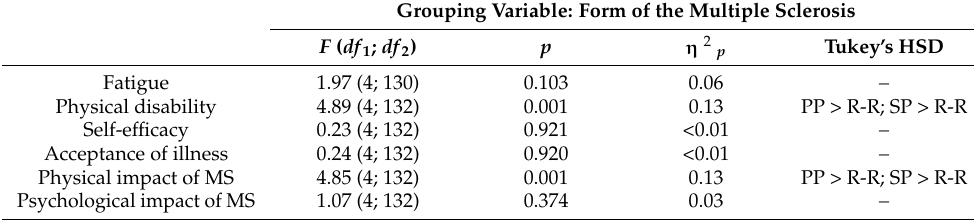
Table 3. Results of the ANOVA